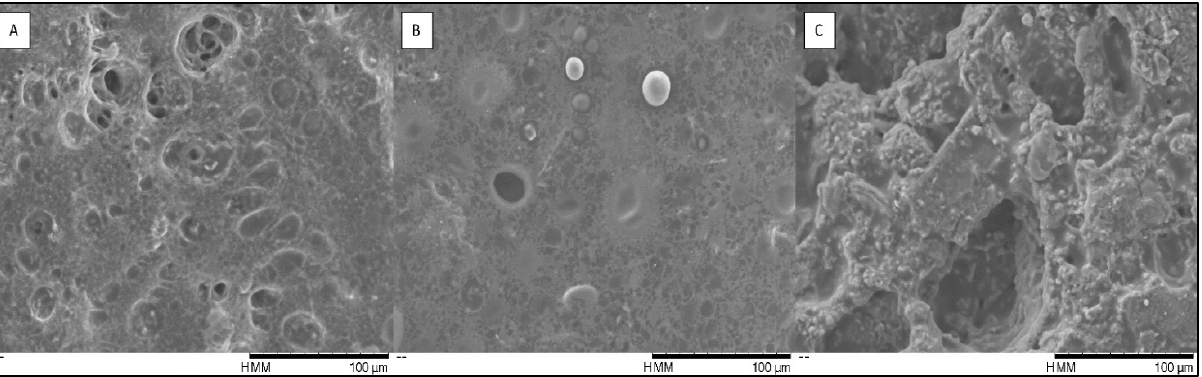
Figure 6. SEM micrographs of emulsified sauces: ControlLab (A). TenA3.4 (B). and Ten7.5 (C). Magnification of 600×.